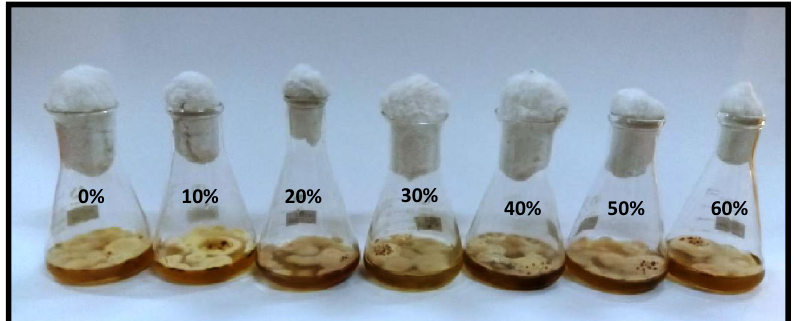
Figure 9. Effect of metabolite concentrations of P. oxalicum on the growth of P.